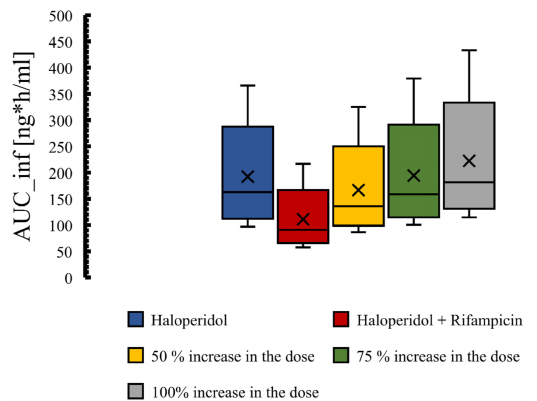
Figure 9. Dosing optimization to overcome the effect of PK interaction between haloperidol and rifampicin. 50%, 75%, and 100% increase in the dose of haloperidol in the combination